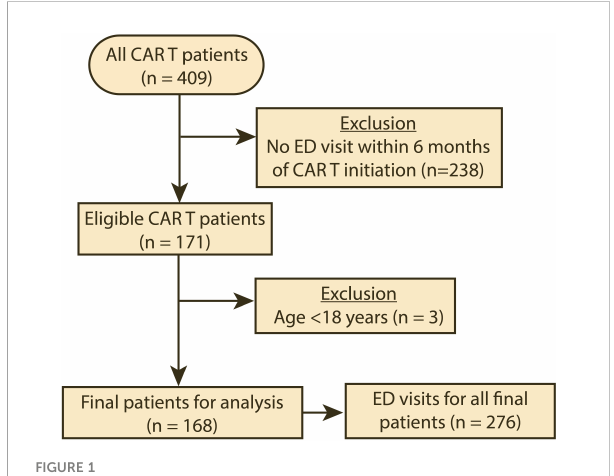
FIGURE 1 Flow diagram of the cohort selection for the period studied (04/01/ 2018 – 08/31/2022). CAR T, chimeric antigen receptor T-cell infusion therapy; ED, emergency